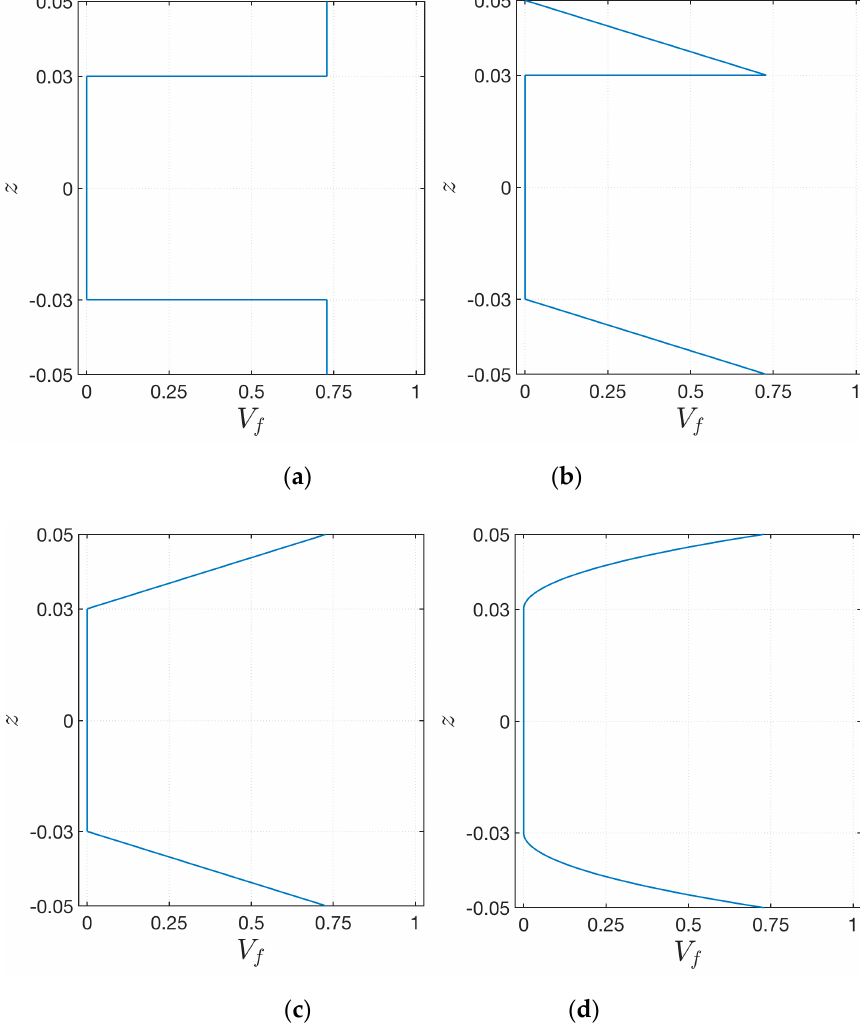
Figure 5. Through-the-thickness representation of the volume fraction distribution V F for several schemes: ( a ) Scheme 1; ( b ) Scheme 2; ( c ) Scheme 3; ( d ) Scheme 4.